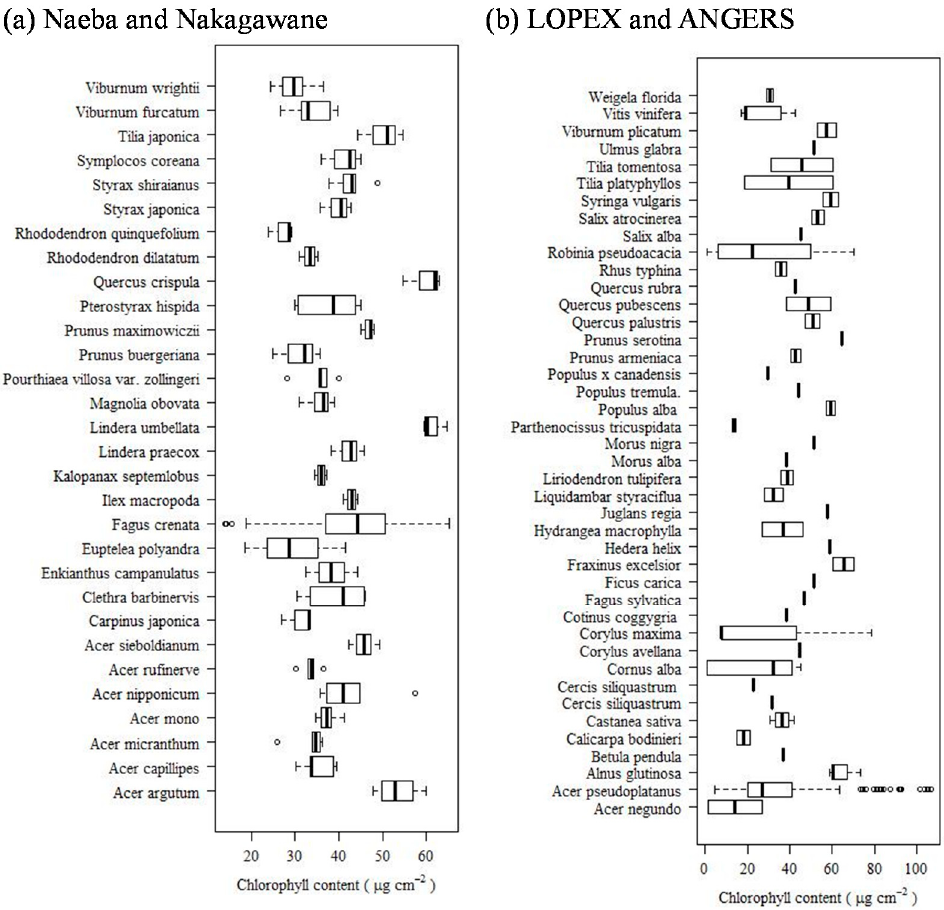
Figure 3. Changes in chlorophyll content for each species; ( a ) our datasets (Naeba and Nakagawane) and ( b ) published datasets (LOPEX and ANGERS). Boxes encompass the 25% and 75% quartiles of the entire dataset. The central solid line represents the median. Bars extend to the 95% confidence limits. Dots represent